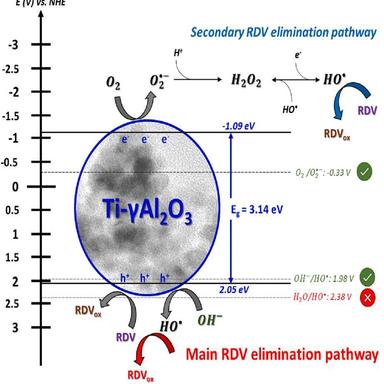
Integrated mechanism of Ti-γAl2O3 activation towards RDV degradation.